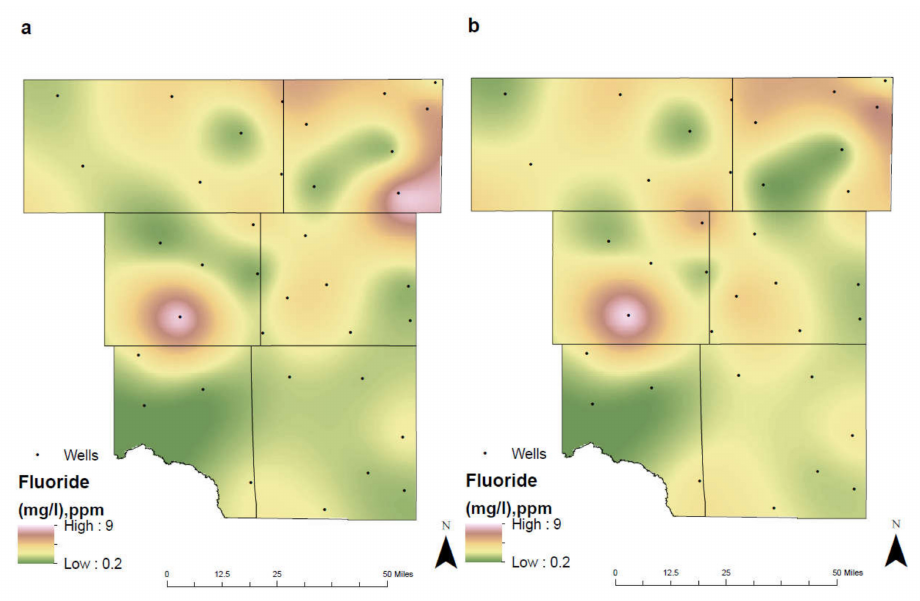
Figure 7. Spatial distribution of fluoride in the study are for ( a ) 1992–2005 and ( b ) 2006–2019.